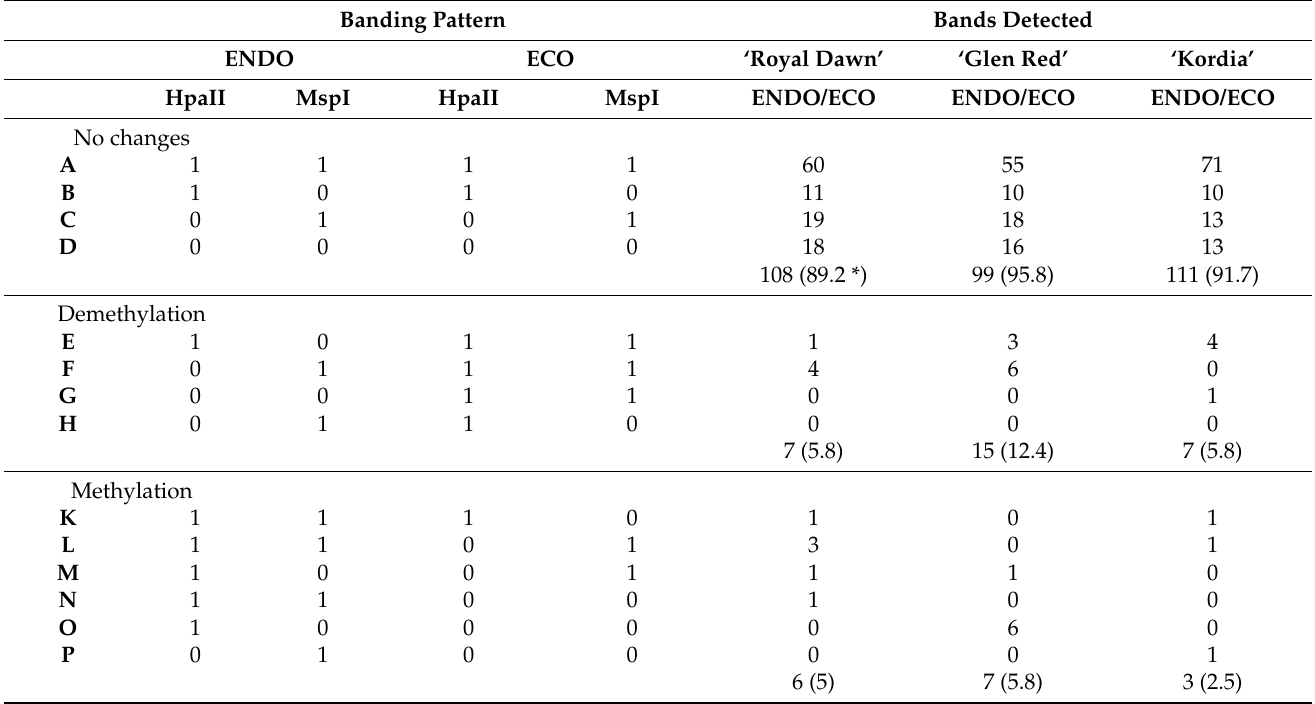
Table 3. DNA methylation patterns in floral buds of ‘Royal Dawn’, ‘Glen Red’ and ‘Kordia’ sweet cherry varieties during endodormancy (ENDO) to ecodormancy (ECO) transition. Banding Pattern Bands Detected ENDO ECO ‘Royal Dawn’ ‘Glen Red’